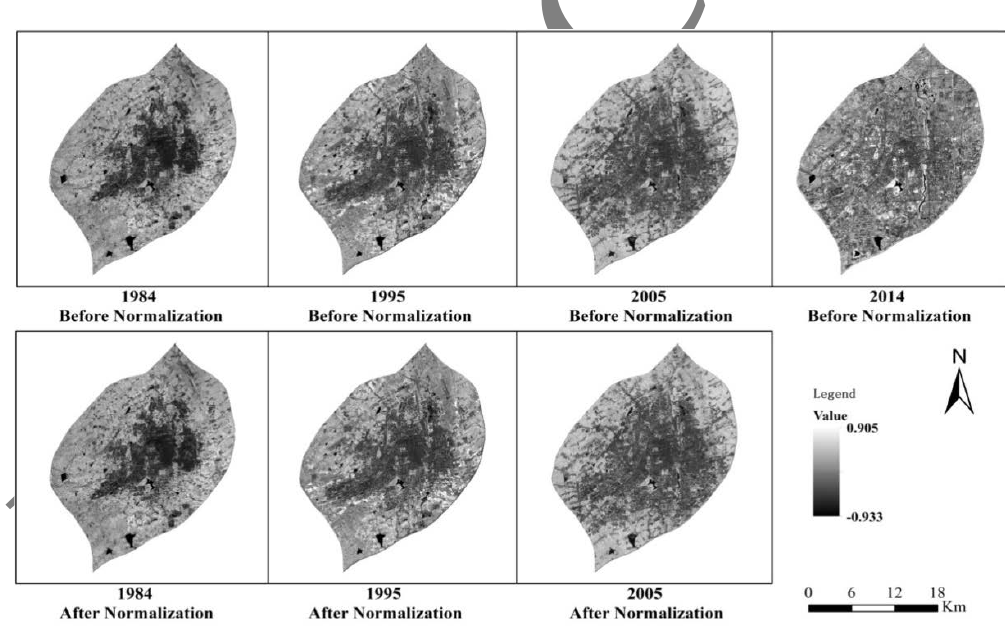
Figure 2. The NDVI images before and after normalization. Table 1. The image normalization coefficients and the correction coefficients for each subject image.